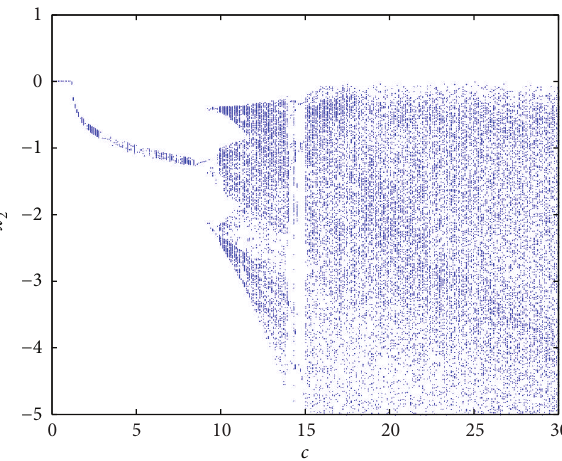
Figure 4: Bifurcation diagram of system (2) versus 𝑐